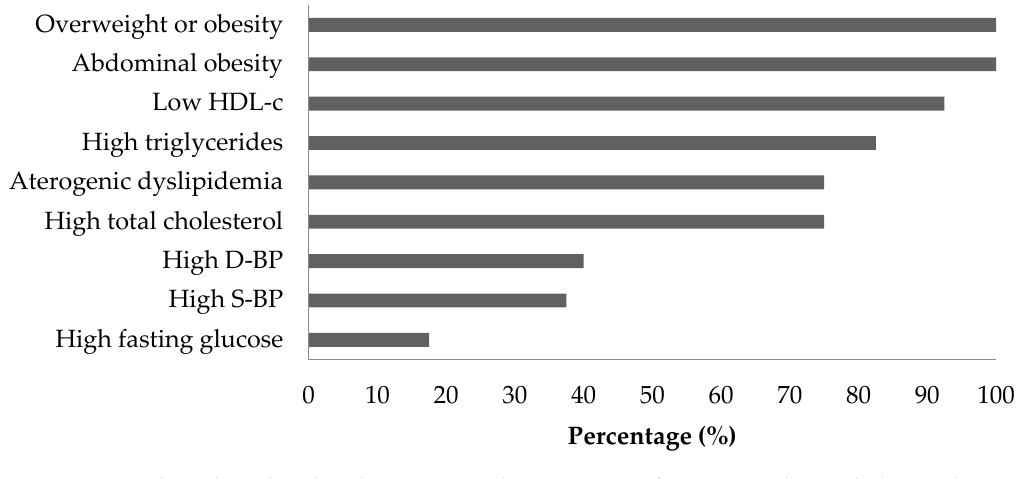
Figure 1. Baseline clinical and anthropometric characteristics of women with metabolic syndrome [according to ATP-III guidelines (37)]. HDL-c: high-density lipoprotein cholesterol. D-BP: diastolic blood pressure. S-BP: systolic blood. Table 2. Changes in anthropometric and biochemical variables in women with metabolic syndrome after consuming agraz compared to placebo.